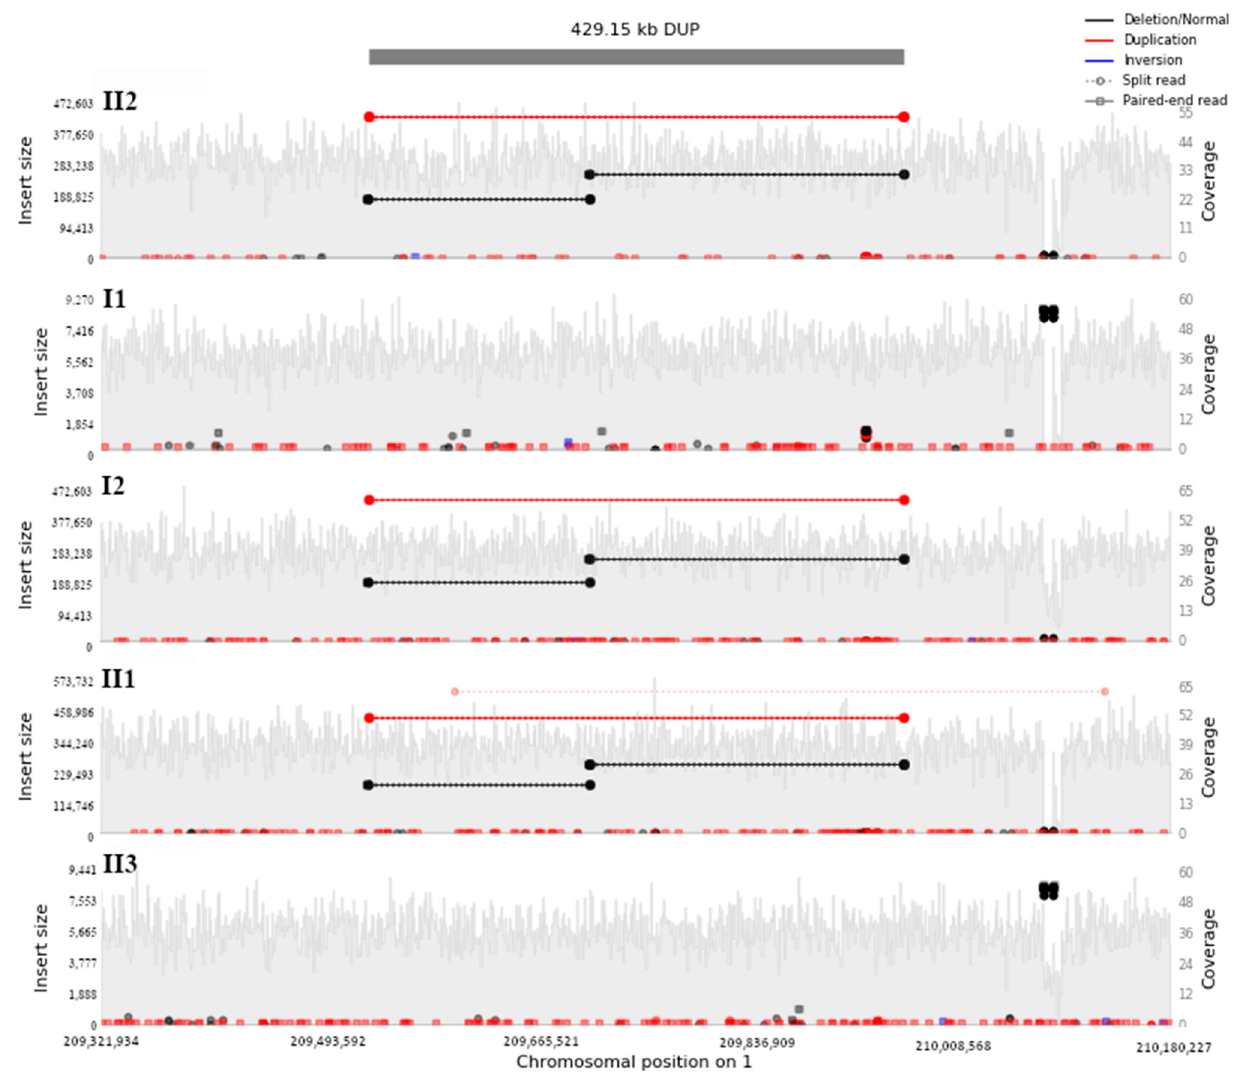
Figure 3. Visualization of the rearranged allele appeared as two consecutive deletions encompassed by a bigger duplication at the same region on chromosome 1 segregating in all affected family members.